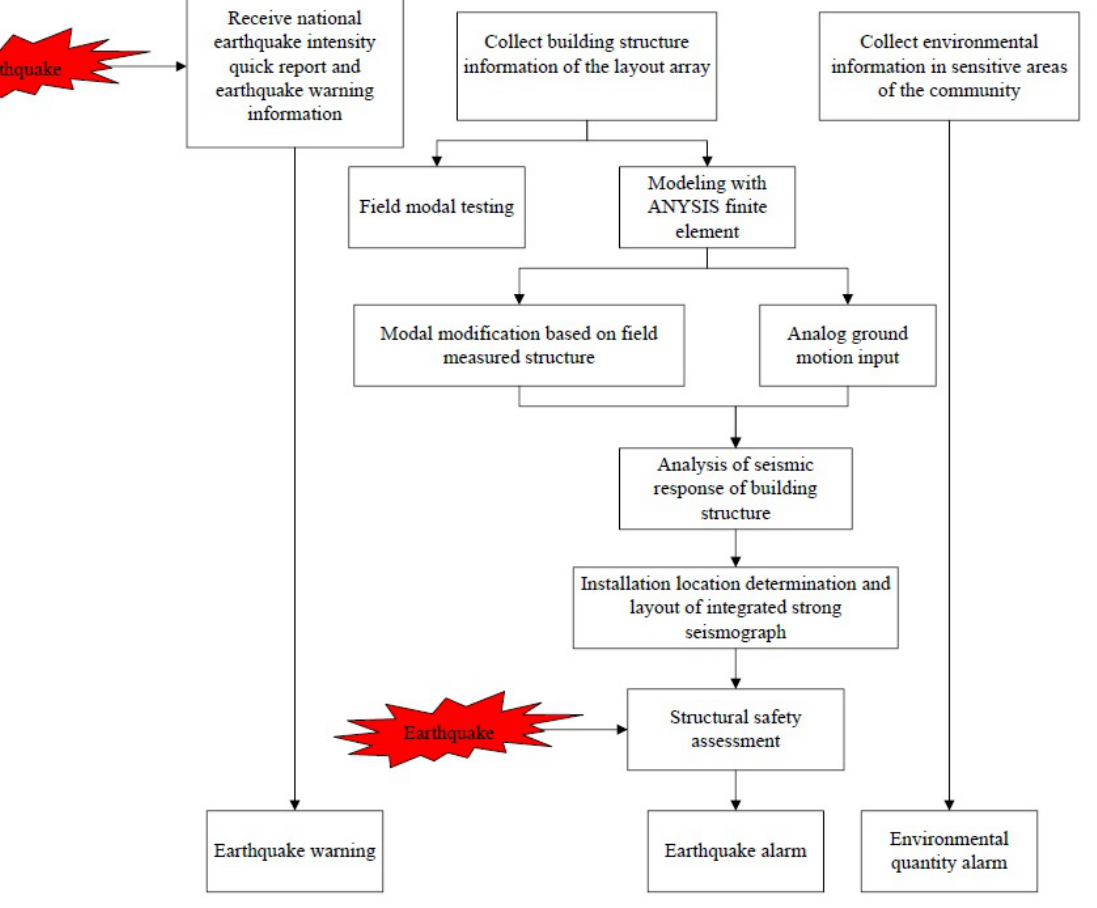
Fig. 1 The overall architecture of the Xinheyuan Smart Community